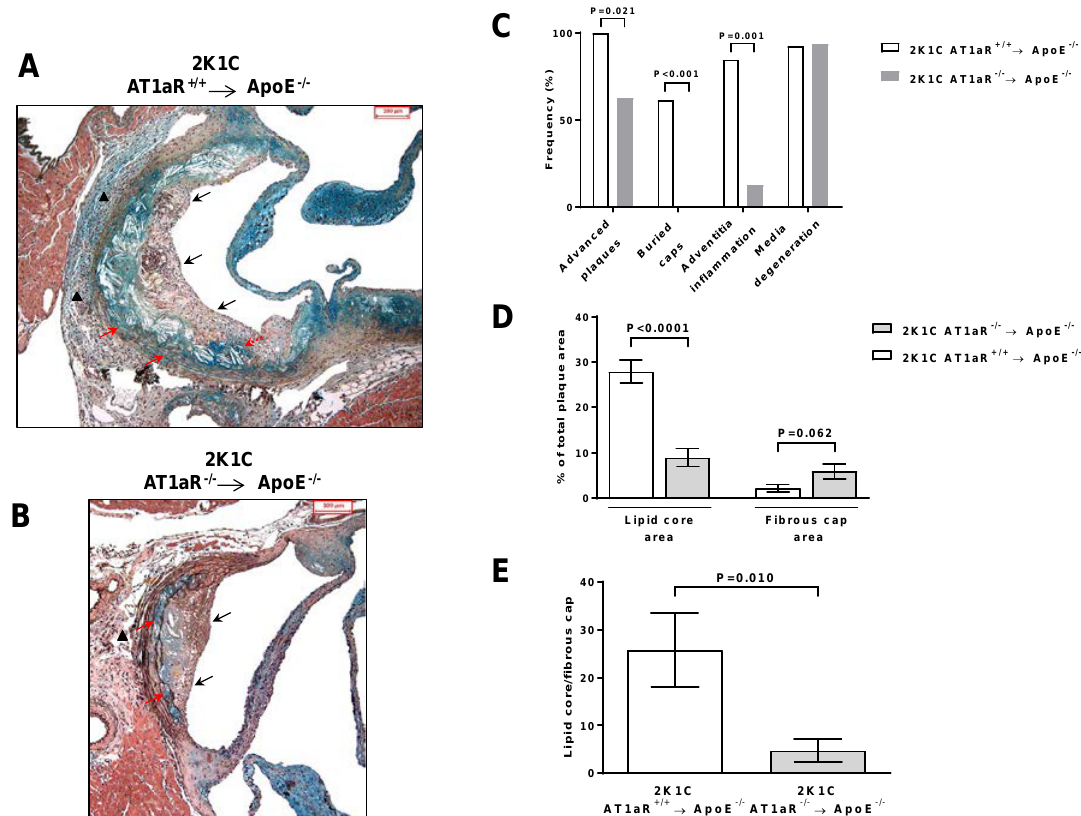
Figure 3. Effect of AT1aR deficiency in BM-derived cells on Ang II-mediated plaque morphology and phenotype. ( A , B ), Representative photographs of Movats pentachrome staining of aortic sinus cross-sections showing different plaque phenotype in 2K1C ApoE − / − mice transplanted with either AT1aR +/+ or AT1aR − / − BM (scale bar = 100 µ m). Vulnerable plaque in 2K1C ApoE − / − mice transplanted with AT1aR +/+ BM characterized by the absence of fibrous cap (black solid arrows), presence of a large lipid core (in blue) containing a vast number of cholesterol clefts, buried cap (red dotted arrow), and extensive adventitia inflammation (black triangle). Note the presence of a plaque in a coronary artery at the bottom of the photograph ( A ) Stable plaque in 2K1C ApoE − / − transplanted with AT1aR − / − BM demonstrating continuous and thick fibrous cap (black solid arrow), presence of small lipid core (in blue) containing a low number of cholesterol clefts, absence of buried cap and of extensive adventitia inflammation (black triangle). ( B ) Presence of media degeneration is present in plaques of both groups (red solid arrows). ( C ) Semi-quantitative analysis of markers of plaque vulnerability (the data represent the frequency of mice presenting the characteristics). ( D ) Quantitative morphometric analysis of lipid core and fibrous cap areas (Movats Pentachrome staining) over the total plaque area. ( E ) Quantification of lipid core to fibrous cap ratio. Data are mean ± SEM. n = 10 to 16 animals per group.